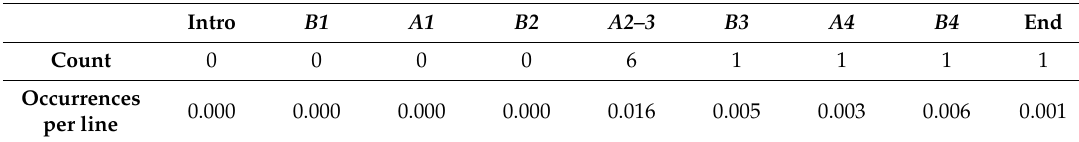
Table 4. Distribution of accented g ó d in Andreas.